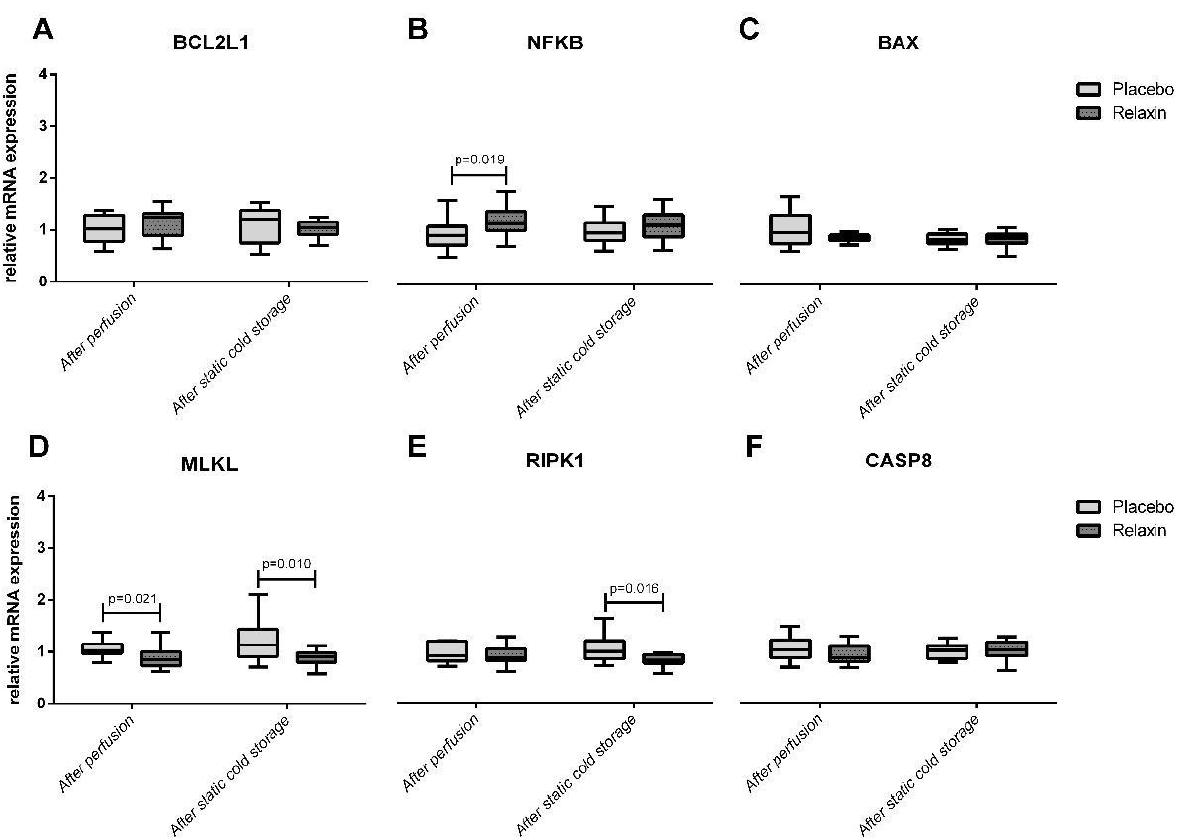
Figure 3. Apoptosis and necroptosis related genes expression in kidney tissue after perfusion and static cold storage in Relaxin and Placebo groups. BCL2L1: BCL2 Like 1; NFKB: Nuclear Factor of Kappa Light Polypeptide Gene Enhancer In B-cells; BAX: BCL2 Associated X Protein; MLKL: Mixed-lineage kinase domain-like protein; RIPKI1: Receptor Interacting Serine/Threonine Kinase 1: CASP8: Caspase 8.